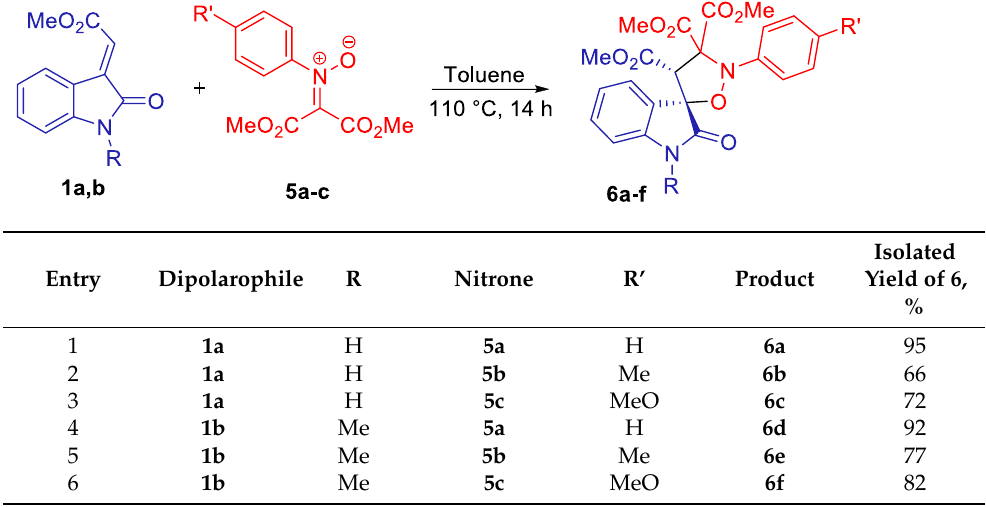
Table 4. Cycloaddition of 2-(2-oxoindoline-3-ylidene)acetates 1a,b with ketonitrones 5a–c .